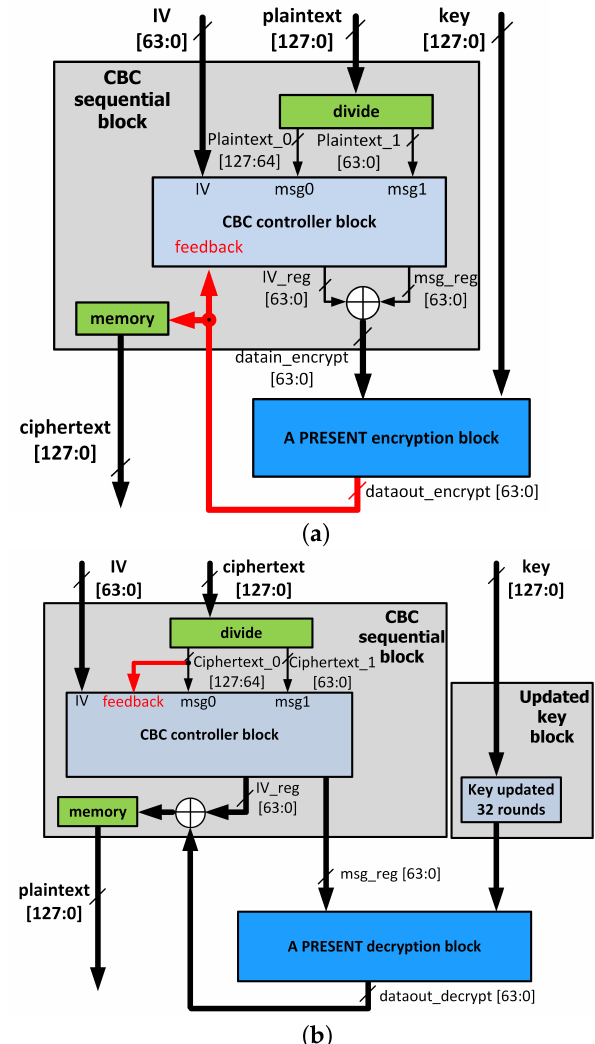
Figure 3. ( a ) CBC-PRESENT encryption and ( b ) CBC-PRESENT decryption.